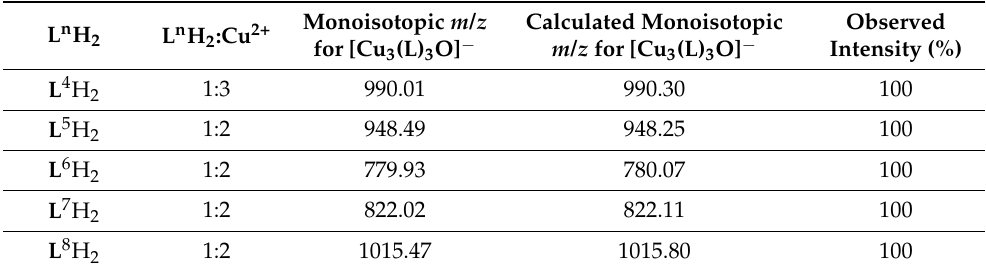
Table 1. The most intense anionic peaks detected in the ESI-MS spectra of MeCN solutions of Cu(OAc) 2 .H 2 O and a selection of the proligands in Figure